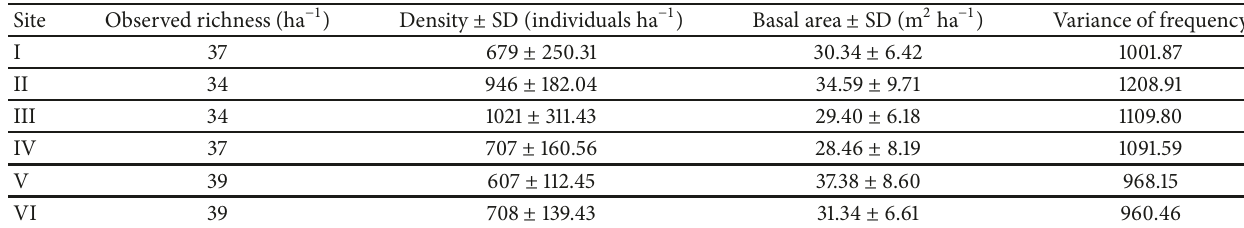
Table 6: Observed richness, total density, and total basal area along the sites of Parsa Wildlife Reserve. Site Observed richness (ha −1